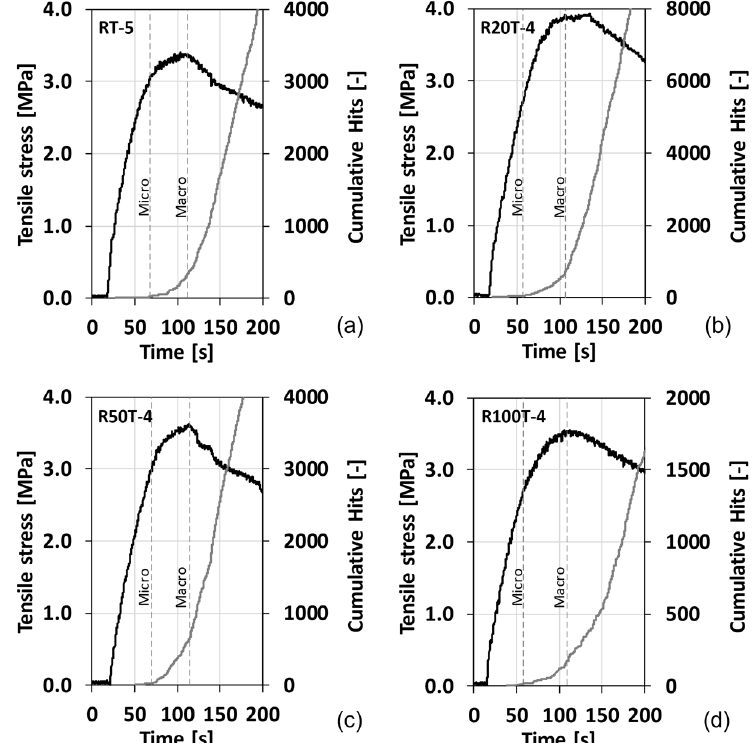
Figure 13. Stress (black line) and cumulative hits (grey line) versus time for RT ‐ 5 (a), R20T ‐ 4 (b), R50T ‐ 4 (c) and R100T ‐ 4 (d). The approximate initiation of micro ‐ and macro ‐ cracking are indicated by dashed